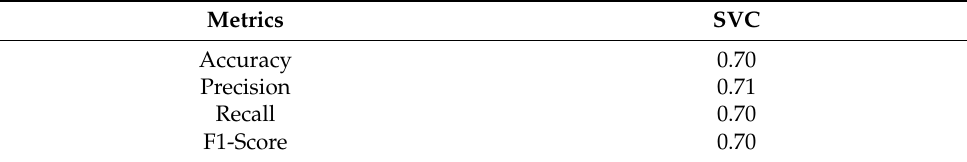
Table 2. SVC-based Performance